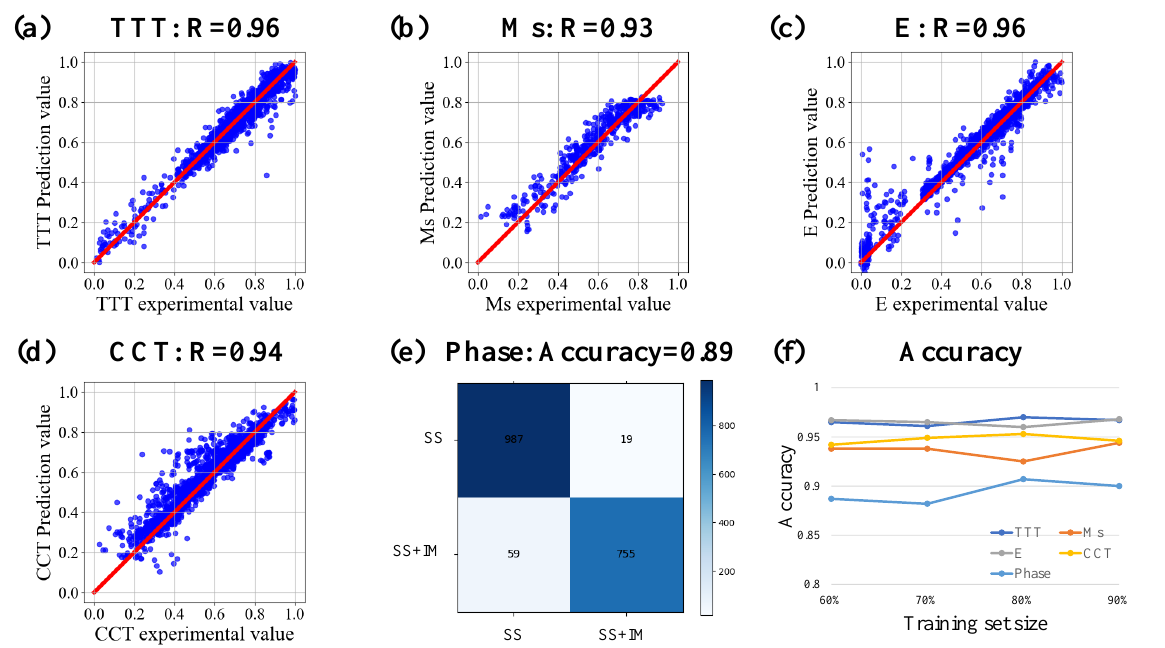
Figure 4. The accuracy analysis of source model. ( a – d ) Correlation analysis of TTT diagram, Ms, E, CCT diagram. ( e ) Confusion matrix of Phase. ( f ) Accuracy of each task under different training set